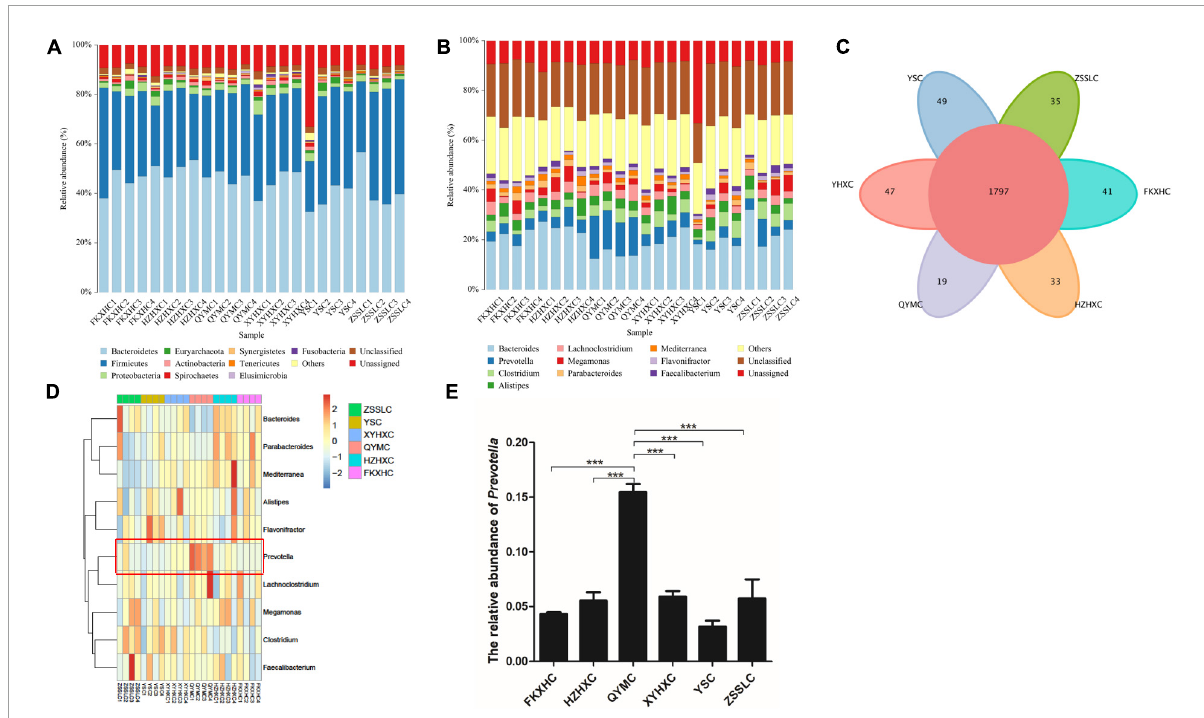
FIGURE2 Taxonomic annotation. (A) Relative abundance at phylum level. (B) Relative abundance at genus level. (C) Venn diagram showing the number of common and unique genus among the six groups. (D) Heatmap representation of taxonomy abundance of the Top 10 dominant genera. (E) Histogram showing the difference in the relative abundance of Prevotella among the six groups. Data are expressed as means ± SEM, *** p <